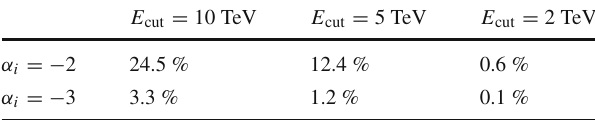
Table 1 List for probabilities of predicting that LHAASO observes at least one photon of ∼ 18 TeV from GRB 221009A within 2000 s E cut = 10 TeV E cut = 5 TeV E cut = 2 TeV α = − 2 24.5 % 12.4 % 0.6 % i = − 3 3.3 % 1.2 % 0.1 α i